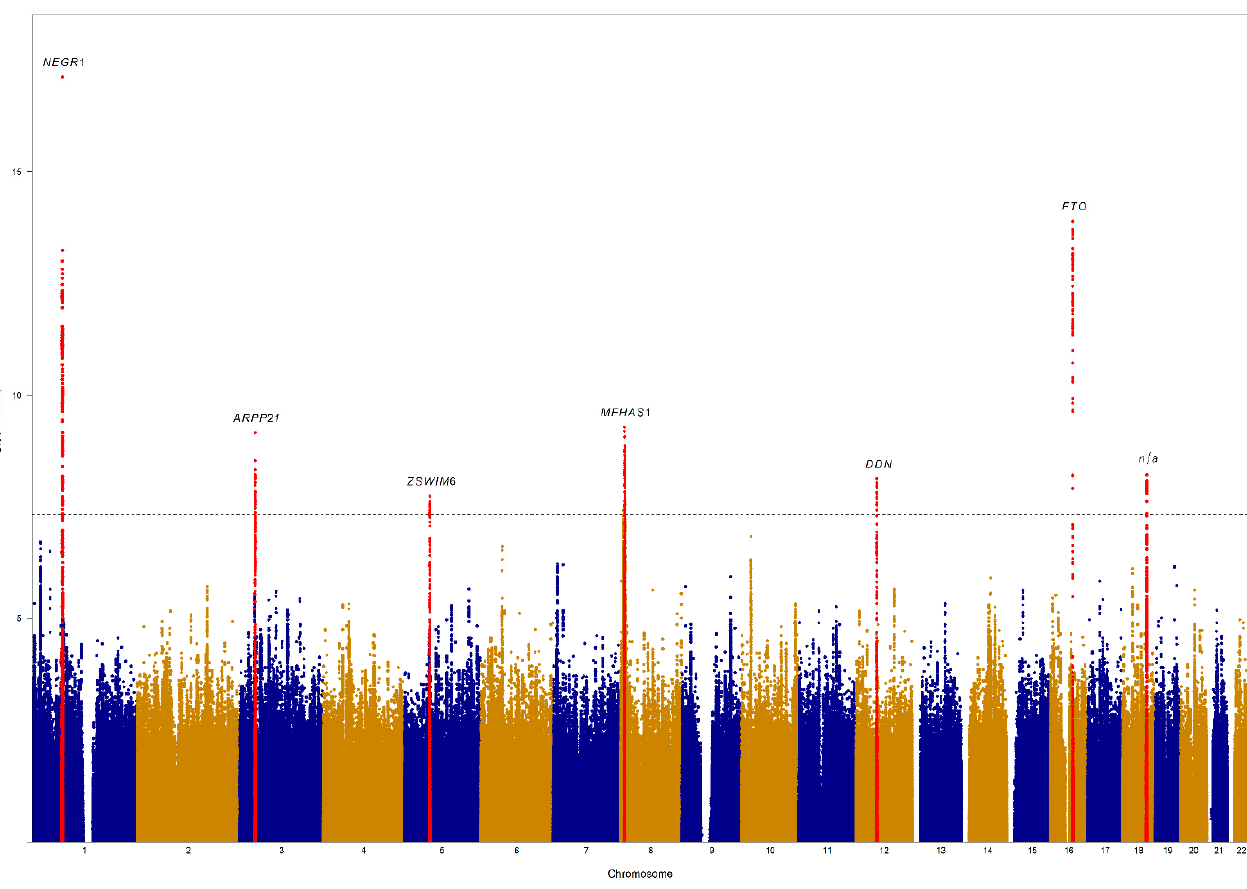
Figure 1. Manhattan plot of the DASH genome wide association study in UK Biobank. The x axis represents the position on each chromosome (represented with alternate colours), while the y axis represents the − log10(P) of SNPs. The dotted line indicates the genome-wide significance threshold ( p < 5 × 10 − 8 ). Only SNPs with p < 0.1 are represented in the figure. Independent genome-wide significant variants (in red) are annotated with the genes associated with DASH based on both MAGMA and VEGAS2 analyses. No genes were associated with DASH on chromosome 18q21.32. DASH, Dietary Approaches to Stop Hypertension; SNPs, single-nucleotide polymorphisms; MAGMA, Multi-marker Analysis of GenoMic Annotation; n/a, no genes